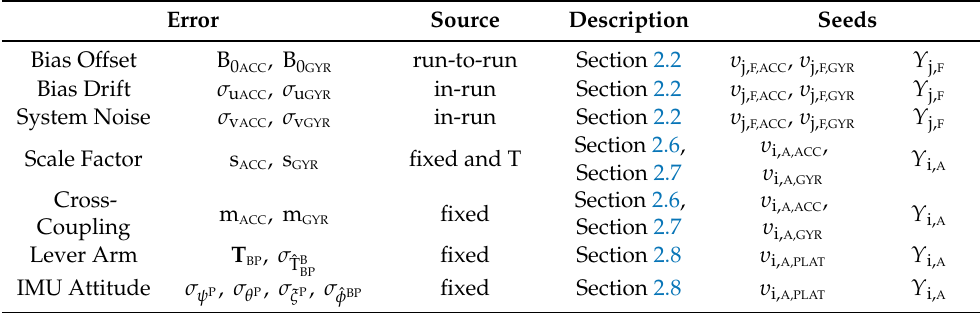
Table 5. Inertial sensor error